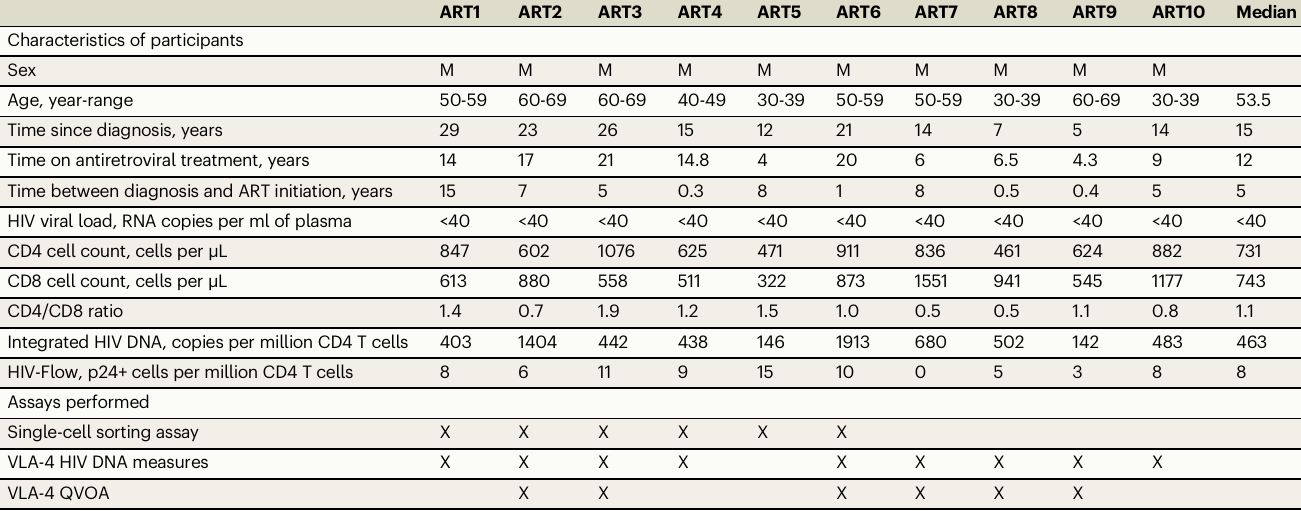
Table 1 | Cohort characteristics. Clinical data of the 10 ART-treated participants at the time of blood